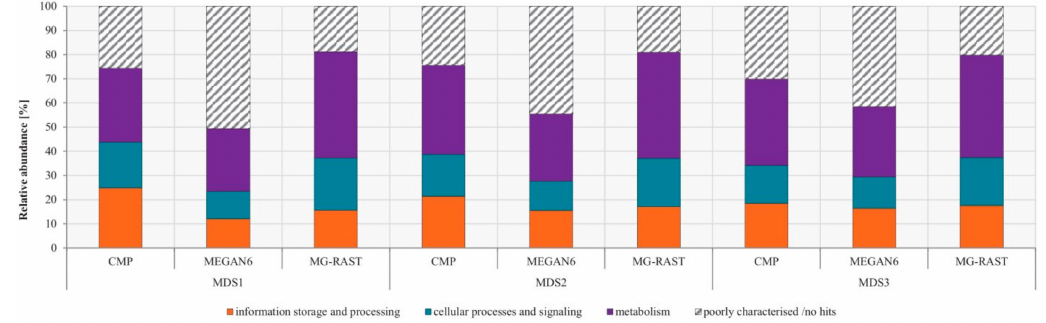
Figure 3. Functional potential of mock communities compared between analysis strategies. The relative abundances were calculated by using absolute read counts per sample and analysis approaches.